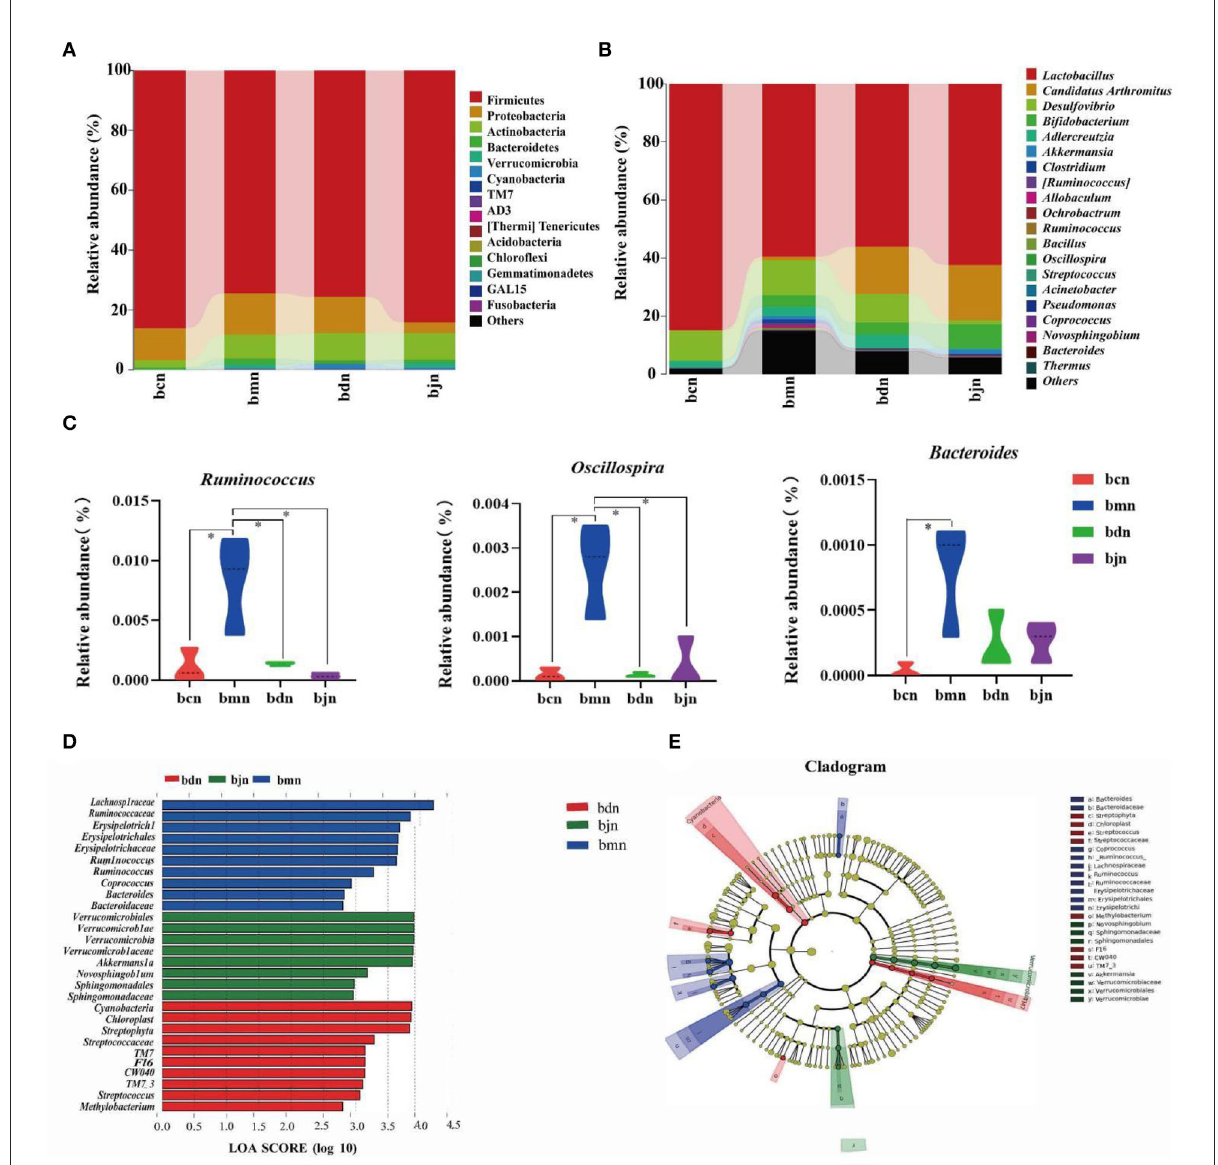
FIGURE5 Dominant bacteria and differential bacteria of intestinal contents microbiota. Data were mean ± SD, n = 3, * p < 0.05. (A) Intestinal contents microbiota composition in the phylum level. (B) Intestinal contents microbiota composition in the genus level. (C) Genus levels of dominant bacteria. (D) LDA scores plot. The horizontal coordinates were the logarithmic scores of LDA for each classification unit. The vertical coordinates were the classification units with significant differences between groups. The longer the length, the more significant the difference was. (E) Cladogram diagram. The circles radiating from the inner to the outer layers of the diagram represented the taxonomic hierarchy of species from phylum to species. Nodes indicated a taxonomic unit at the taxonomic level. Letters identified the names of taxonomic units with significant differences between groups. bcn: normal saline-treated basal diet group; bmn: normal saline-treated high-fat diet group; bdn: DO traditional decoction-treated high-fat diet group; bjn: lipid-lowering decoction-treated high-fat diet